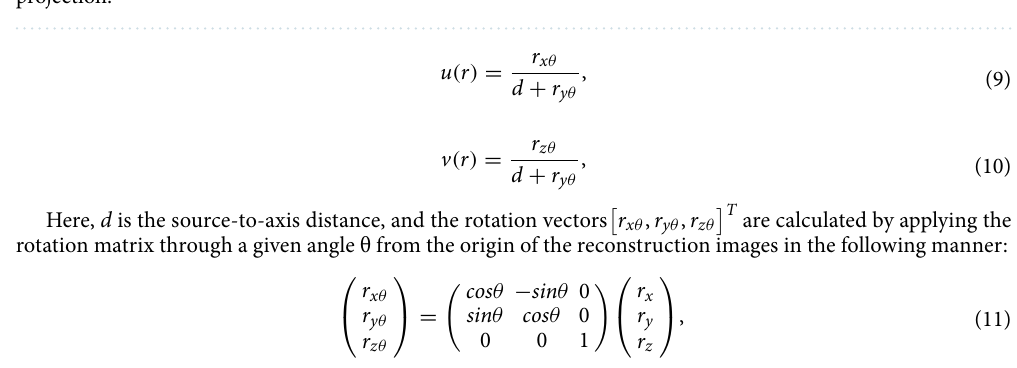
Figure 4. Resampling process using 2D tensor product of 1D cubic B-spline interpolation from n-th filtered